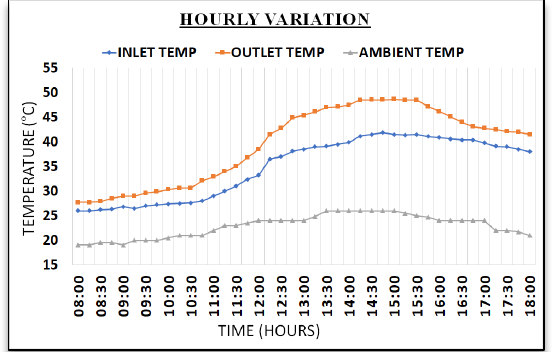
Figure 17. Temp vs Time values observed as on rainy day